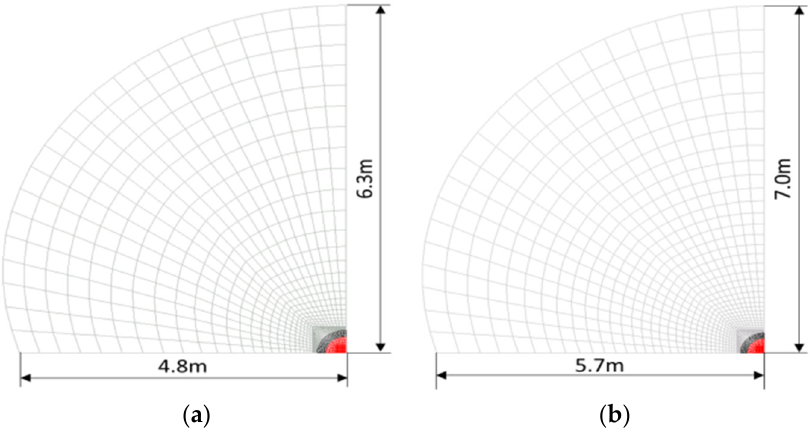
Figure 15. Road tunnel simulation model schematic and mesh generation: ( a ) tunnel area: 54 m 2 ; ( b ) tunnel area: 72 m 2 .